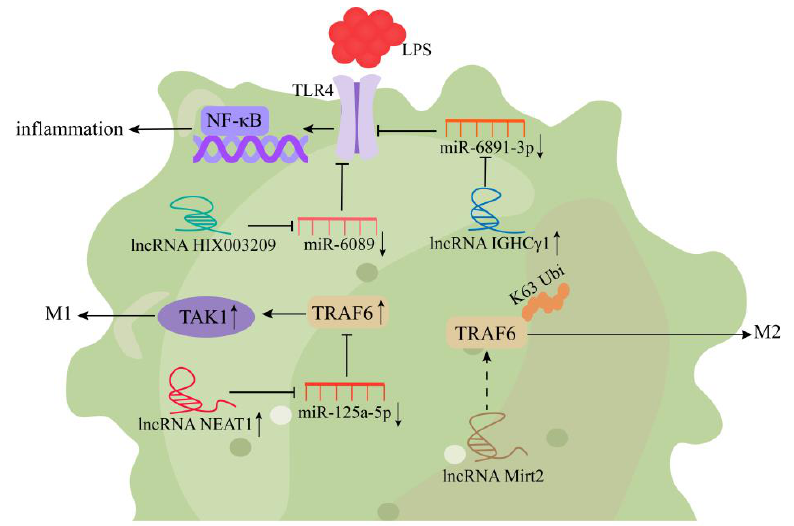
Figure 1. Mechanism of lncRNAs for regulating macrophage proliferation and differentiation. LncRNA Mirt2 promotes the M2 polarization of macrophages by inhibiting the Lys63 (K63) ubiquitination of TRAF6. LncRNA NEAT1 increases the expression of TRAF6 and TAK1 by binding to miR-125a-5p, eventually leading to M1 polarization of macrophages. Overexpression of lncRNA IGHC γ 1 promotes the activation of the NF- κ B signaling pathway by regulating miR-6891-3p/TLR4 axis, thereby aggravating the TLR4-mediated inflammatory response of macrophages. LncRNA HIX003209 promotes the expression of TLR4 and activation of NF- κB in macrophages by targeting miR-6089.